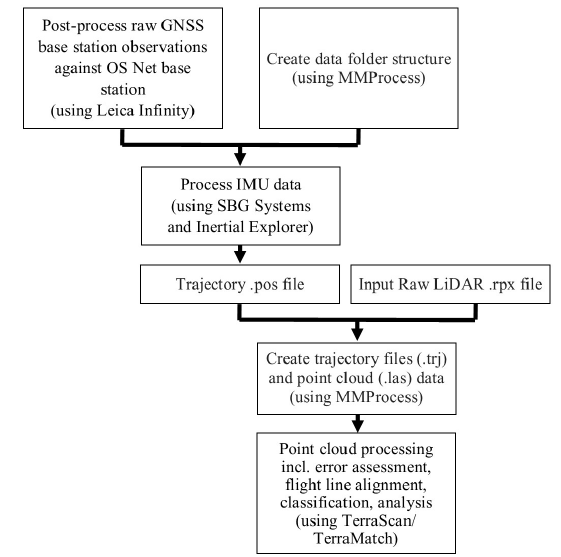
Figure 6. Data processing workflow.